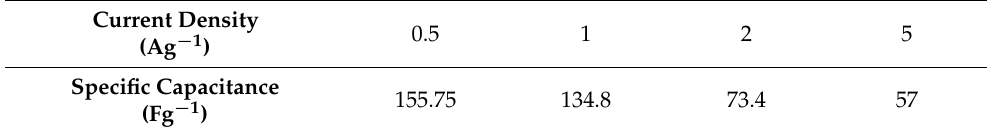
Table 2. Specific capacitance evaluated using GCD